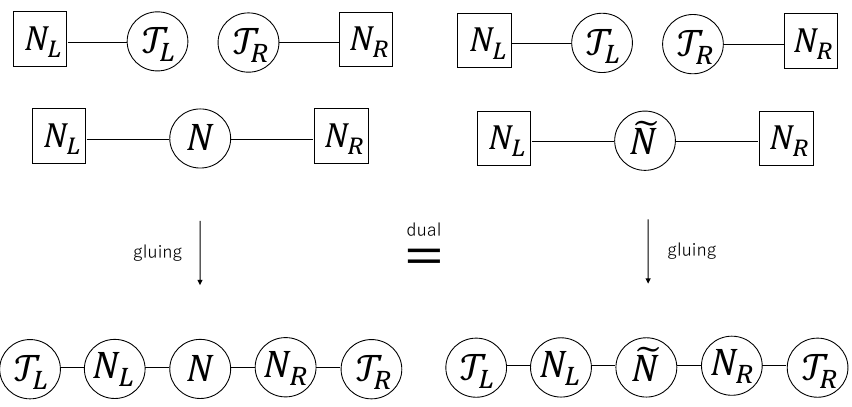
Figure 11 . Gluing the three theories. The duality of the local theory implies the duality of the glued theory as